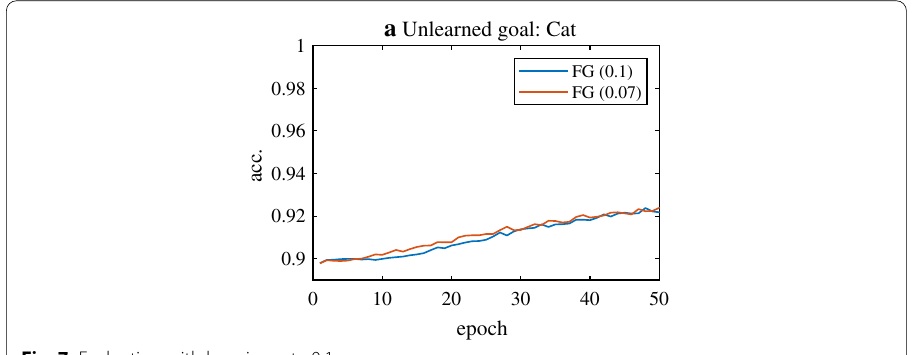
Fig. 7 Evaluation with learning rate